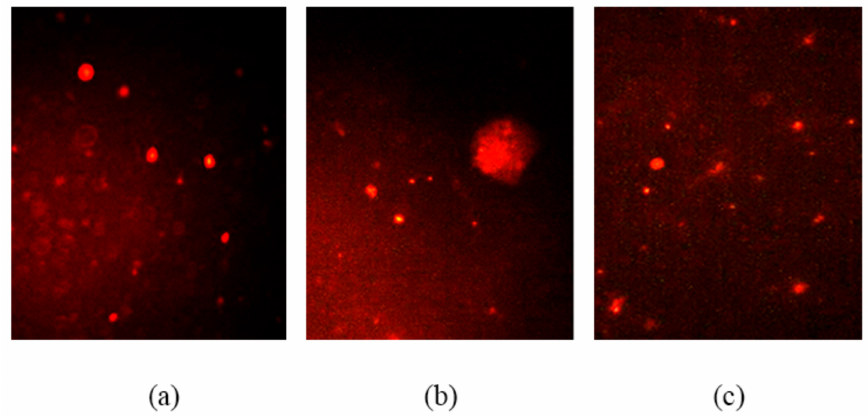
Figure 3. Fluorescence microscopy image of liver cell comets of male rats exposed to 250 mg TiSiO 4 NPs/kg b.w.; ( a ) control, ( b ) 7 days post-treatment, and ( c ) 28 days post-treatment.